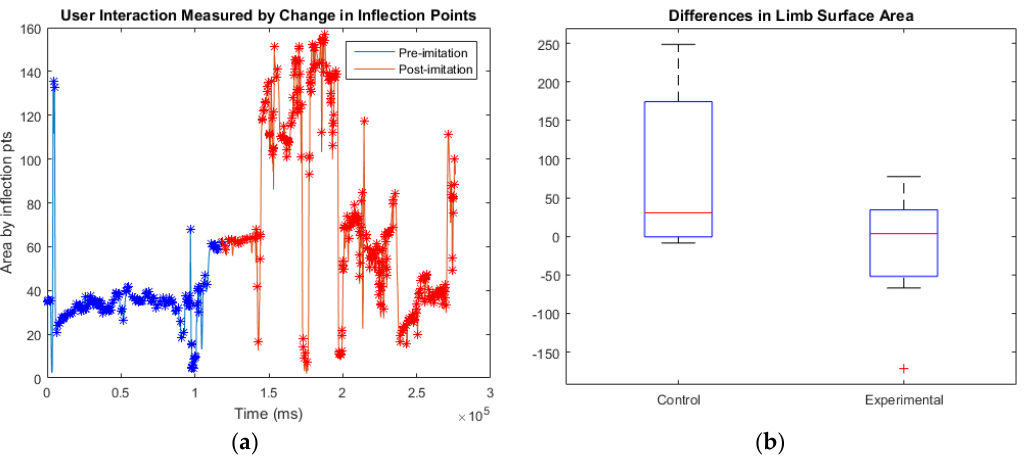
Figure 5. ( a ) The posture tracking of a participant who responded very noticeably to the imitative gesture with an increase in average body surface area. The imitation time stamp is indicated by a switch from blue to red markers; ( b ) Box-and-whisker plot comparisons of the change in surface area of participant posture for control and experimental participants.